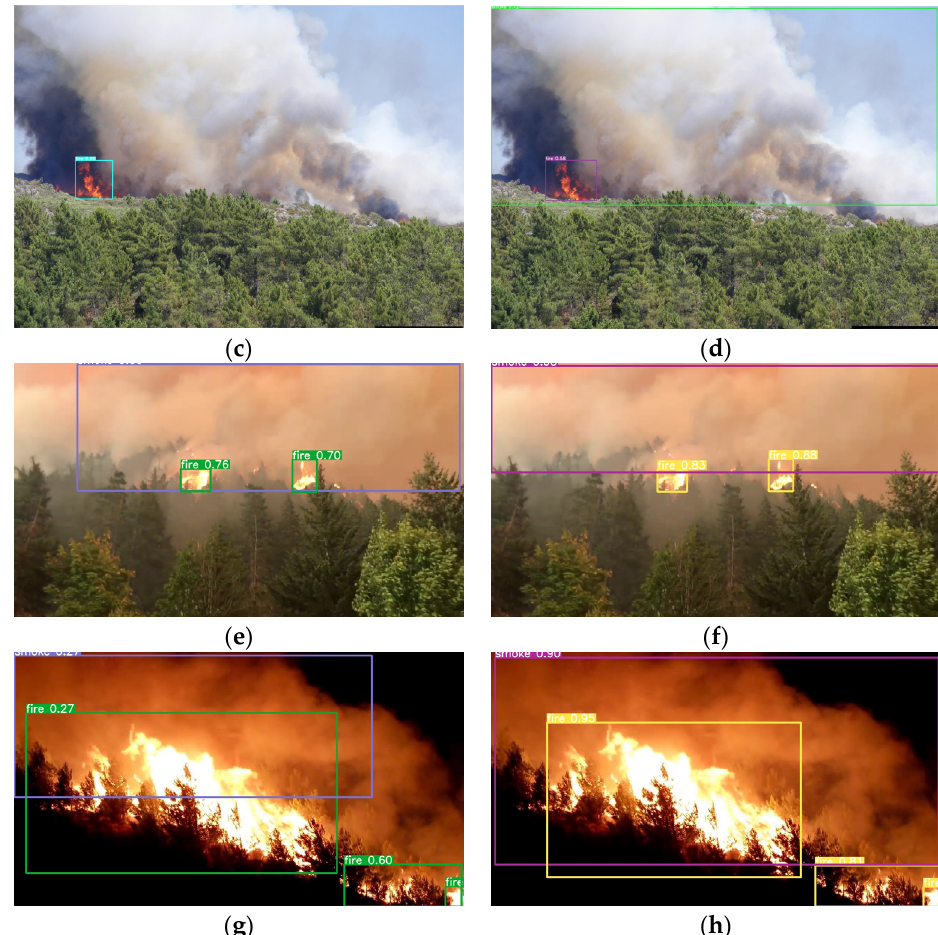
Figure 7. ( a , c ) are the detection results of the YOLOv5 detection model, neither of which identifies smoke well; ( b , d ) are the detection results of the improved model, which can accurately identify smoke and forest fires, and the values are also improved; ( e , g ) are the detection results of YOLOv5 detection model, in the case of both fire and smoke detection without ( f , h ) after the detailed improve- ment of the model, and the improved model recognition value